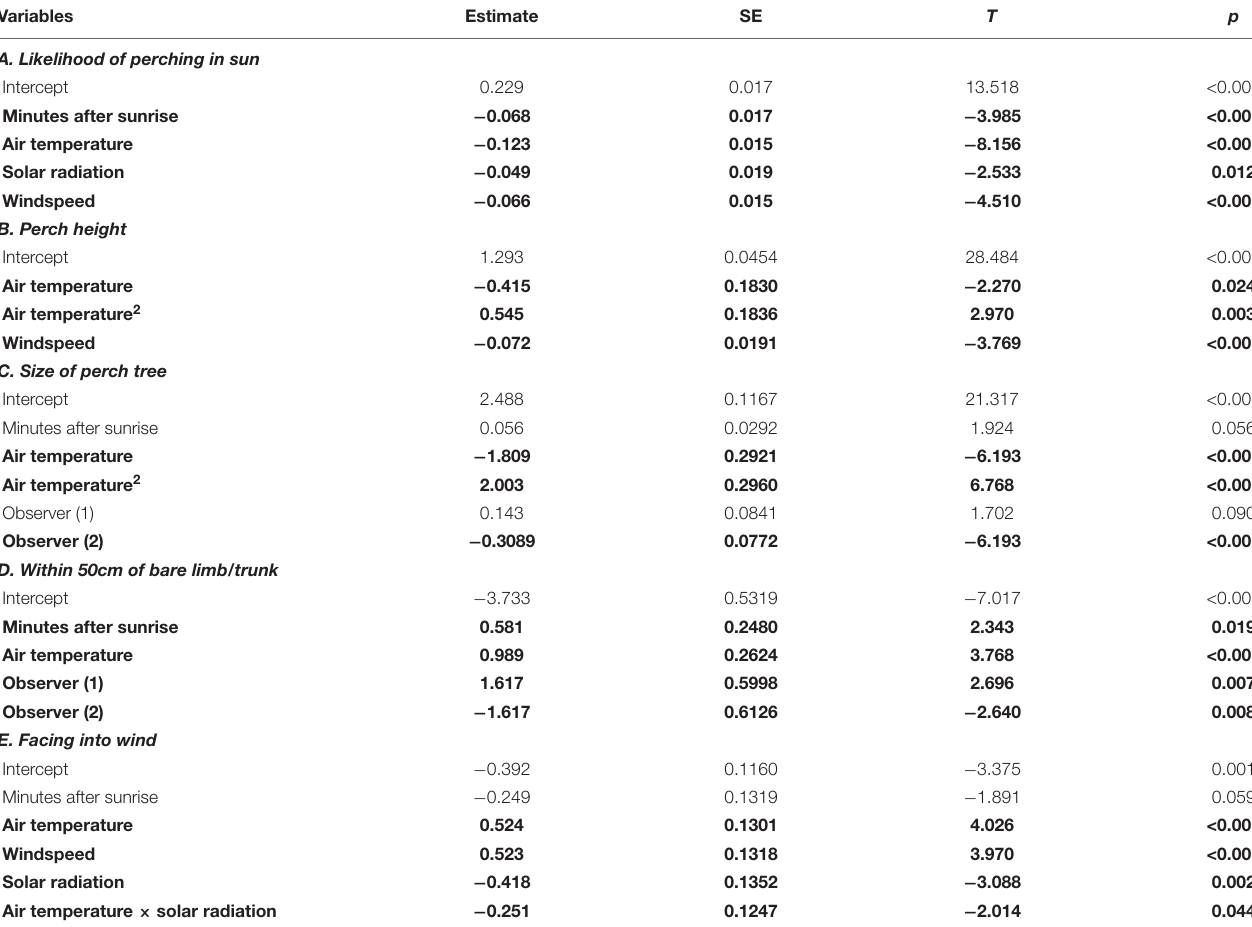
TABLE 4 | Results of REML or GLMM mixed effects models testing for factors associated with perch choice.